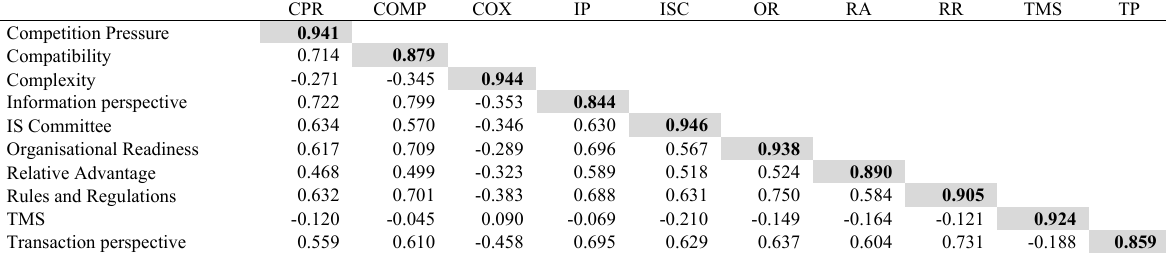
Correlations and Square roots of AVEs for